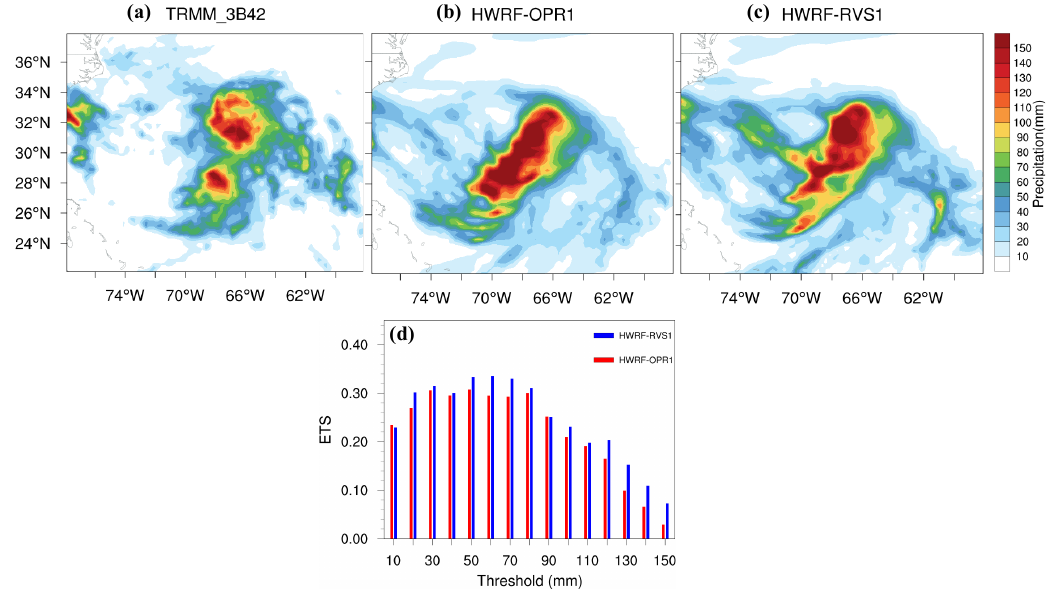
Figure 11. Accumulated precipitation (unit: mm) from ( a ) Tropical Rainfall Measuring Mission (TRMM) 3B42, ( b ) HWRF-OPR1 and ( c ) HWRF-RVS1 during the rapid weakening of Hurricane Joaquin from 1800 UTC 03 to 0000 UTC 05 October 2015. ( d ) The equitable threat score (ETS) of the 30-h accumulated precipitation from HWRF-OPR1 (red bars) and HWRF-RVS1 (blue bars) compared against TRMM 3B42 precipitation observations with thresholds of 10, 20, 30, 40, 50, 60, 70, 80, 90, 100, 110, 120, 130, 140 and 150